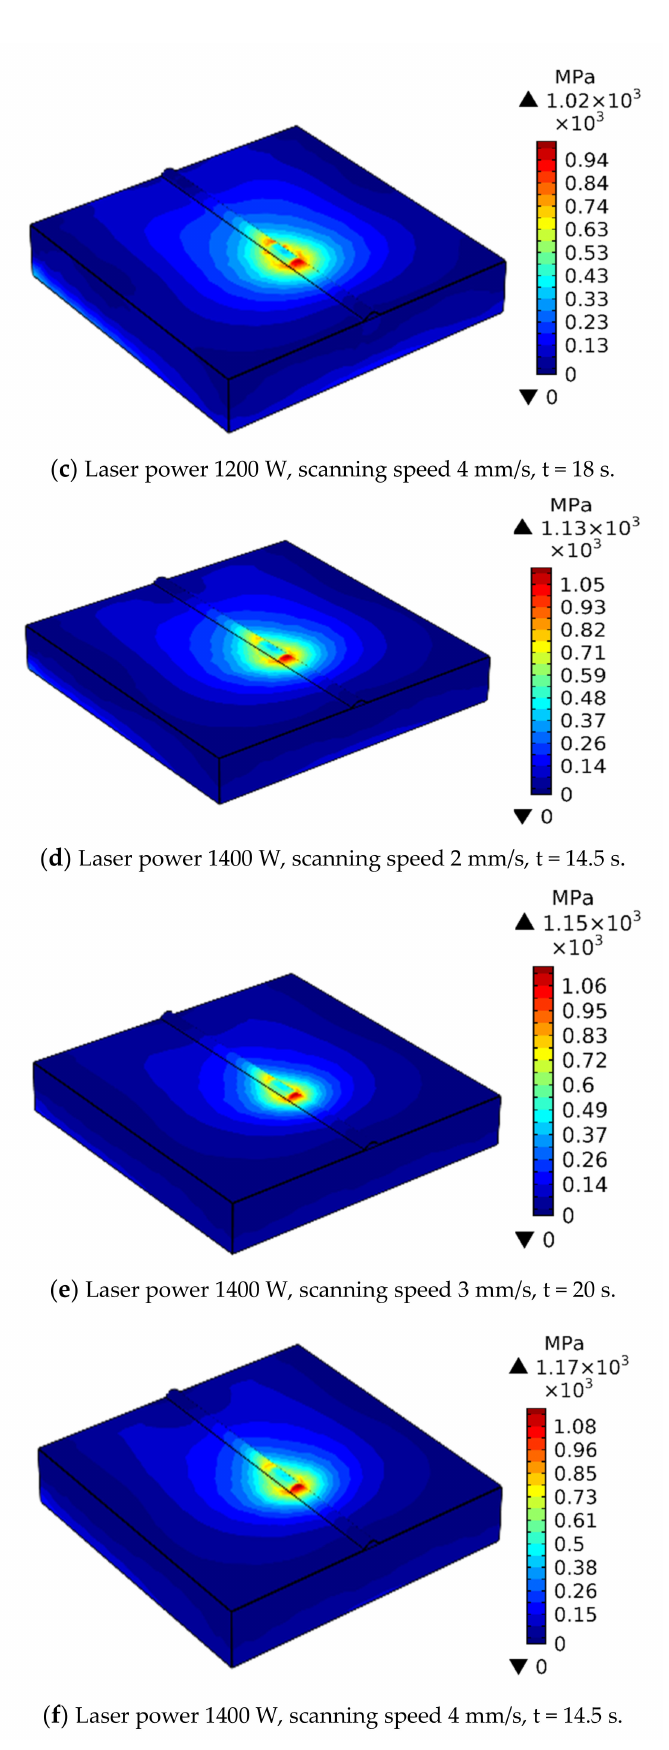
Figure 6. Von Mises thermal stress distribution at the same location under six